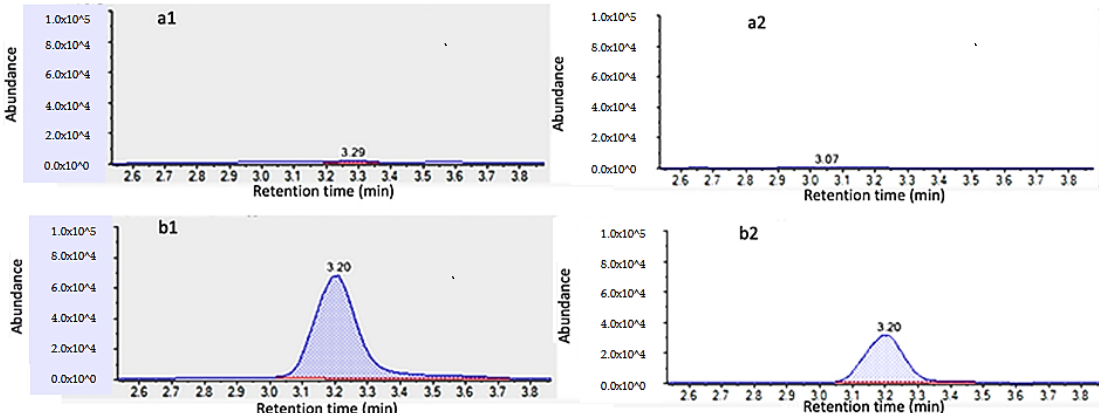
Figure 2. UHPLC–MS/MS chromatogram of ( a ) blank cucumber sample, monitoring transitions at m/z 222/141 ( a1 ) and m/z 222/114 ( a2 ), and (b) blank cucumber sample spiked with 10 µg/kg of quinmerac, monitoring transitions at m/z 222/141 ( b1 ) and m/z 222/114 ( b2 ).